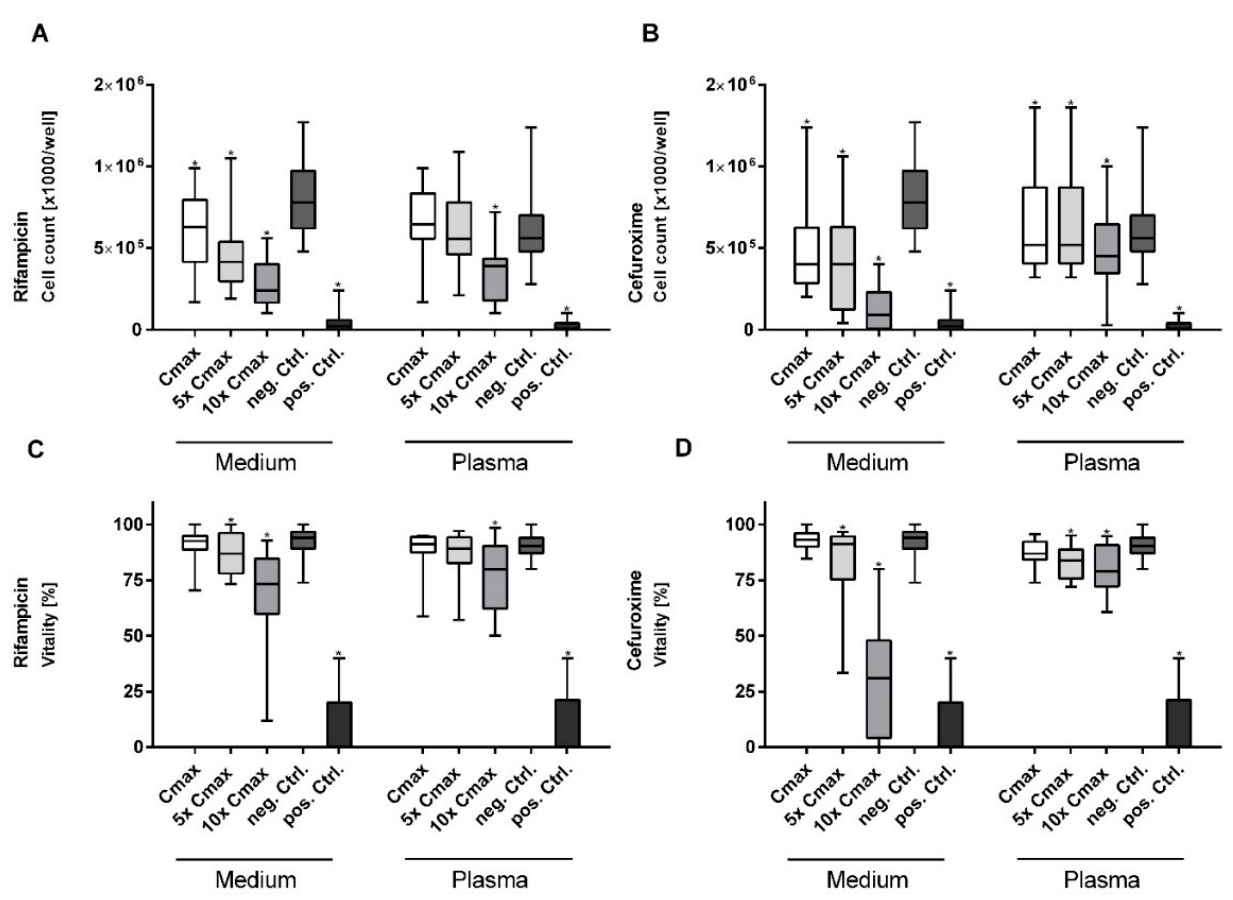
Figure 2. The upper graphs represent a dose-dependent decrease in vitality after hepatocytes treatment with ( A ) rifampicin and ( B ) cefuroxime with a stepwise increase in concentration. The lower graphs show a dose-dependent decrease in cell count after treatment of hepatocytes with ( C ) rifampicin and ( D ) cefuroxime with a stepwise increase in concentration. * denotes a significant decrease in cell count compared with the control group. p < 0.05 was considered statistically significant.